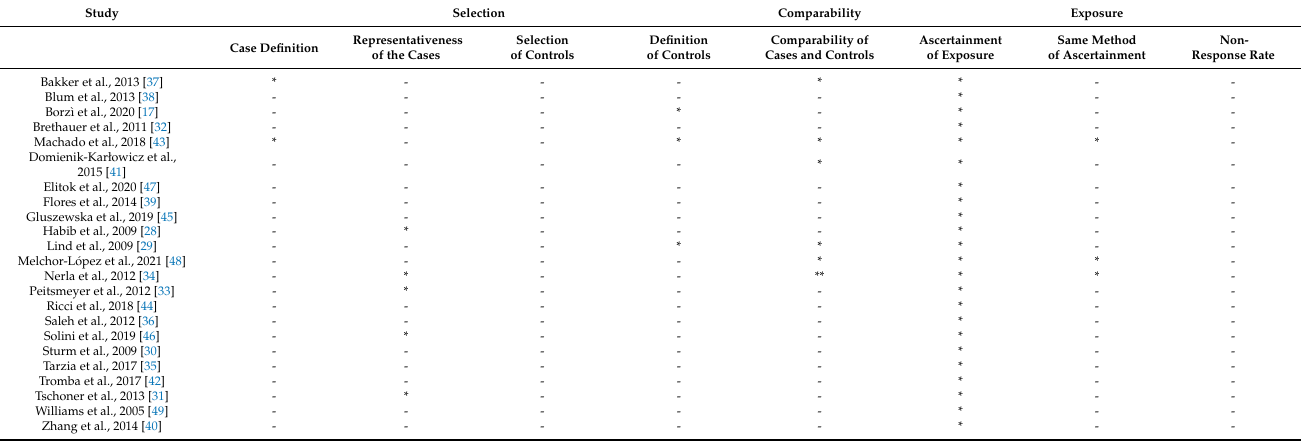
Table 3. Quality of bias assessment of the included publication in accordance with the Newcastle- Ottawa scale.